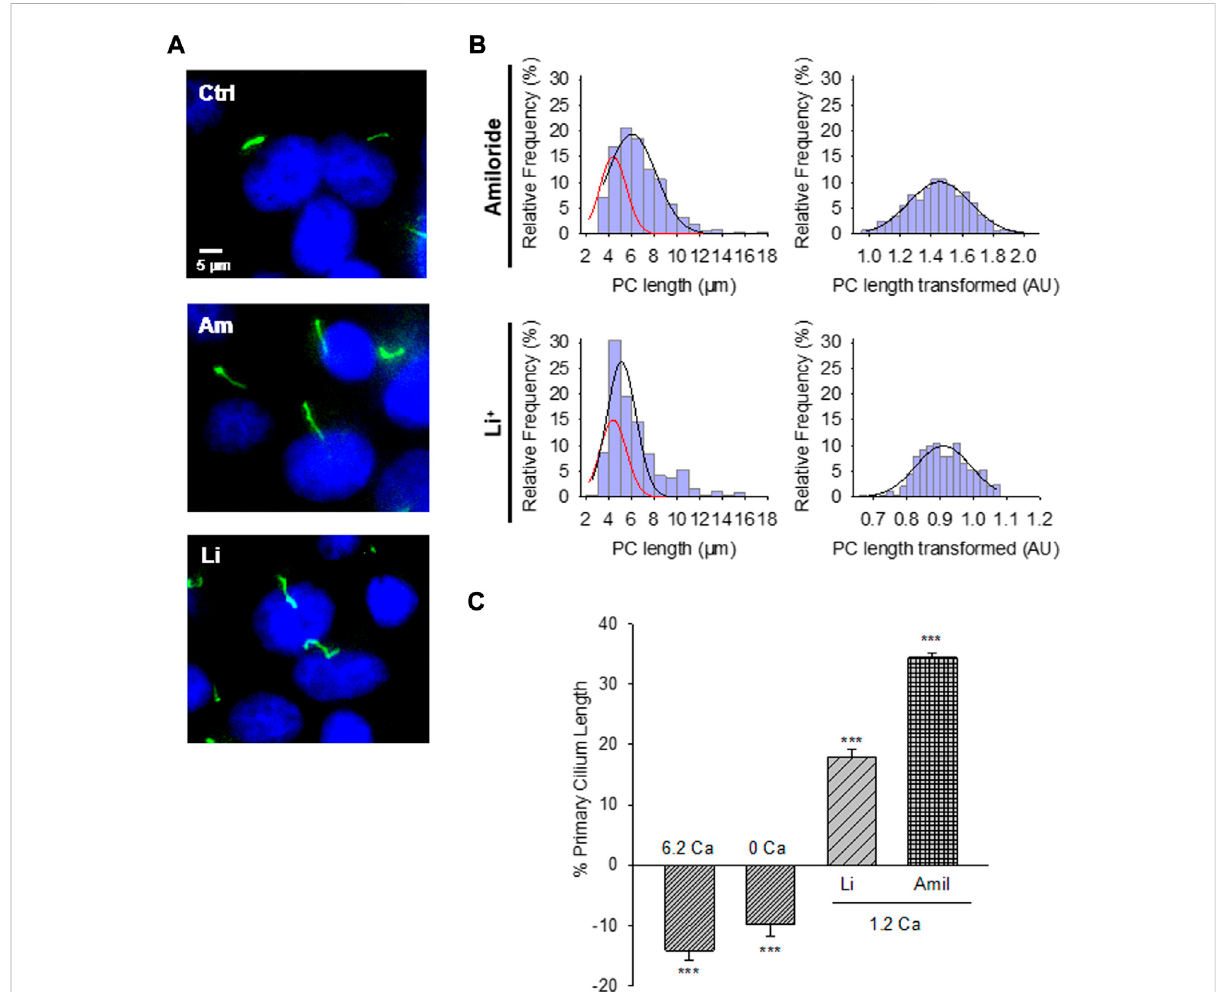
Effect of PC2 channel inhibitors on the primary cilium length of wild-type LLC-PK1 cells. (A) Acetylated- α -tubulin antibody immunolabeling of LLC-PK1 cells (FITC, Green) to observe the length of primary cilia under control (Ctrl, Top Panel) condition and the presence of either amiloride (200 μ M, Middle Panel), or LiCl (10 mM, Bottom Panel). Cells were incubated in normal 1.2 mM Ca 2+ . Images were obtained with ×60 objective. (B) Red lines indicate control distribution. Histograms of ciliary length measurements in normal Ca 2+ and the presence of either amiloride (Top) or LiCl(Bottom) areshownbefore(Left)andafter (Right),Box-Coxtransformation. AnotNormalleft-skeweddistributionofdataisobservedbeforethe transformation. (C) Bar graphs of percentage increase (positive bars) or decrease (negative bars) in the length of the primary cilium under various conditions, including Free- and high (6.2 mM) Ca 2+ external conditions, as well as incubations with LiCl (10 mM) and amiloride (200 μ M) respect to the 1.2 Ca condition. Li + and amiloride were added in the presence of external 1.2 mM Ca 2+ . All data are the mean ± SEM of percentage change compared to the control condition in normal Ca 2+ . Asterisks indicate statistical signi fi cance: *** p < 0.001 vs. control, as evaluated by one-way